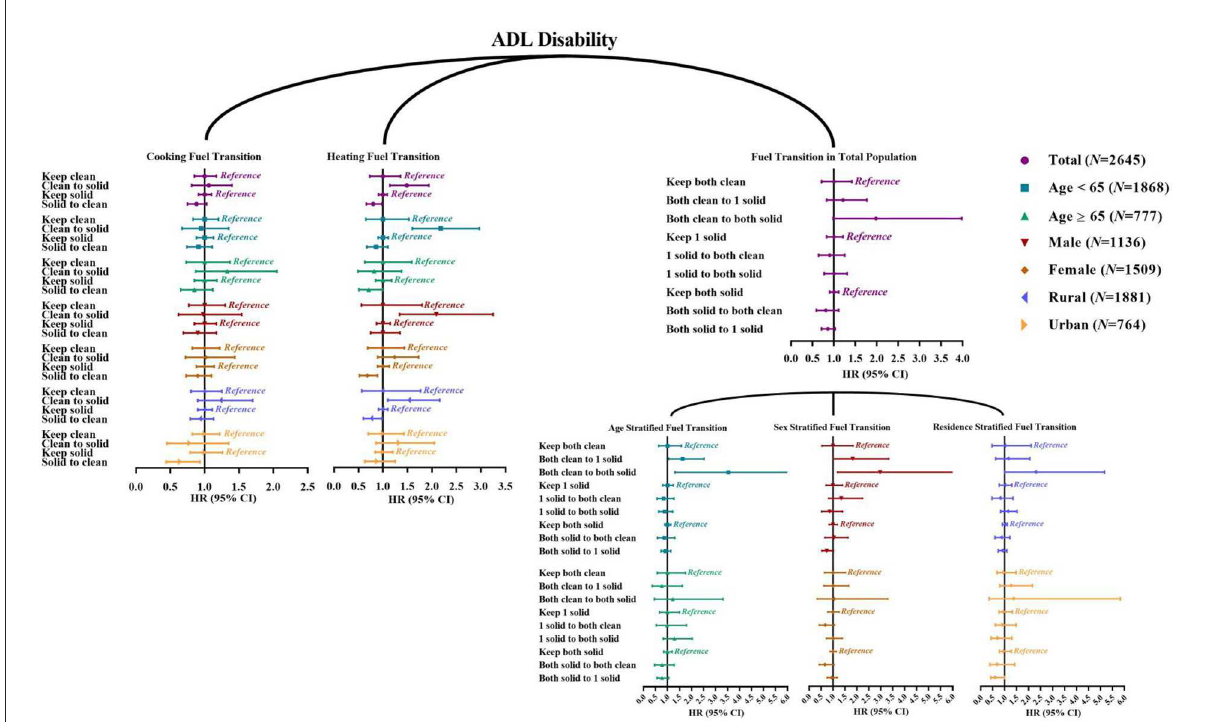
FIGURE2 Hazard ratio (95% confidence interval) of fuel usage transitions with new-onset ADL disability: Cox proportional-hazards model. ADL, activities of daily living. The reference of “Clean to solid” is “Keep clean;” the reference of “Solid to clean” is “Keep solid;” the reference of “Both clean to 1 solid” and “Both clean to both solid” is “Keep both clean;” the reference of “1 solid to both clean” and “1 solid to both solid” is “Keep 1 solid;” the reference of “Both solid to both clean” and “Both solid to 1 solid” is “Keep both